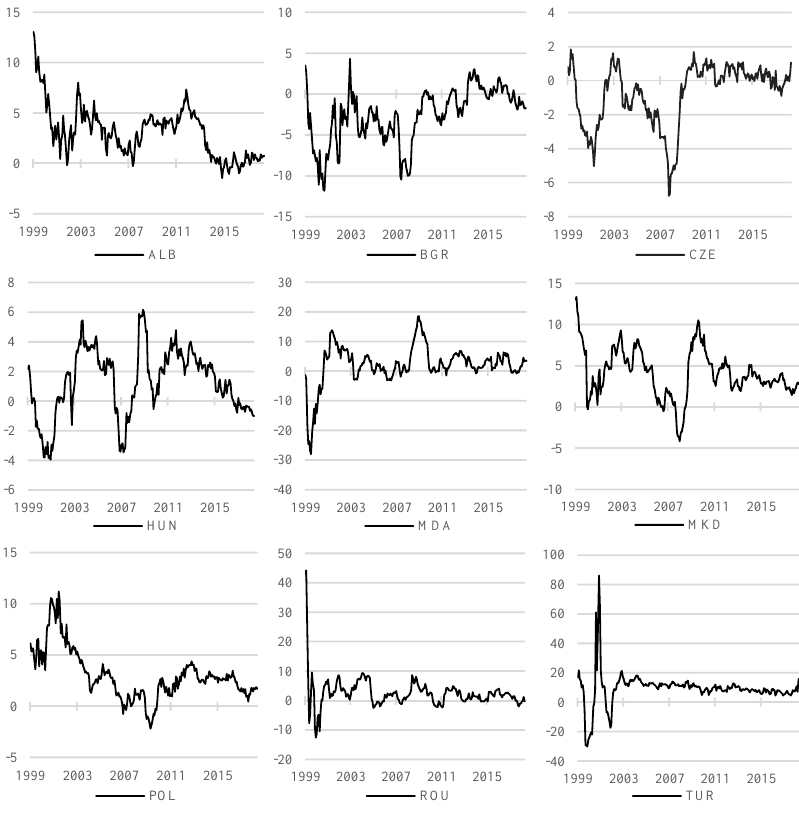
Figure 1. Real interest rates differentials between the CEE countries and the